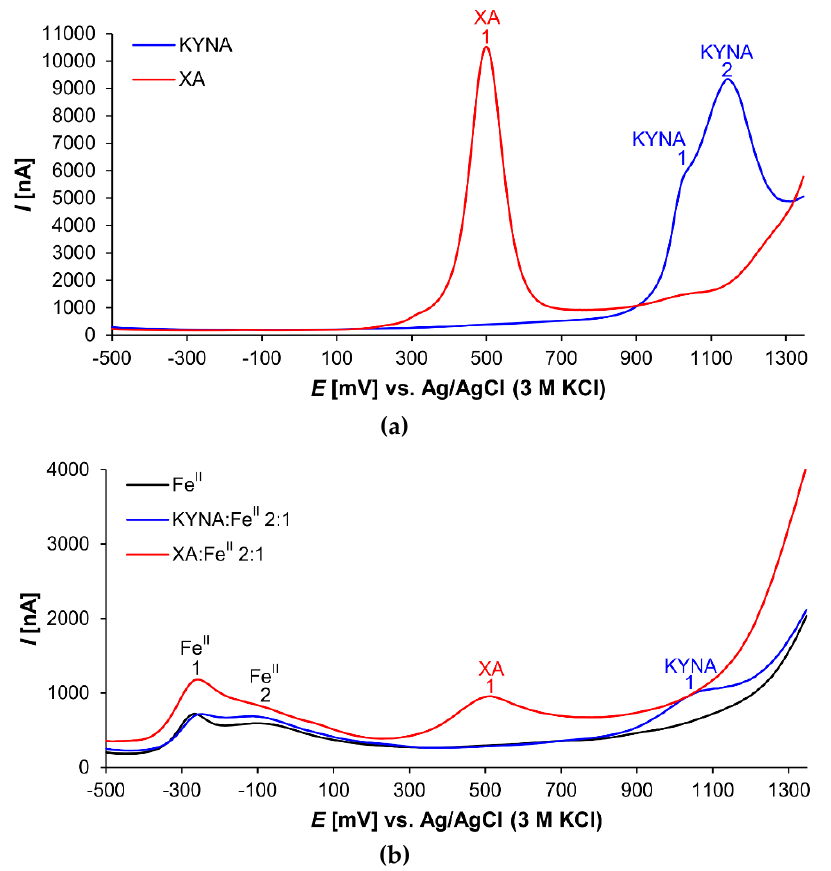
Figure 3. Differential pulse voltammograms of ( a ) KYNA or XA solutions and ( b ) solutions of Fe II , 2:1 KYNA:Fe II or 2:1 XA:Fe II mixtures.